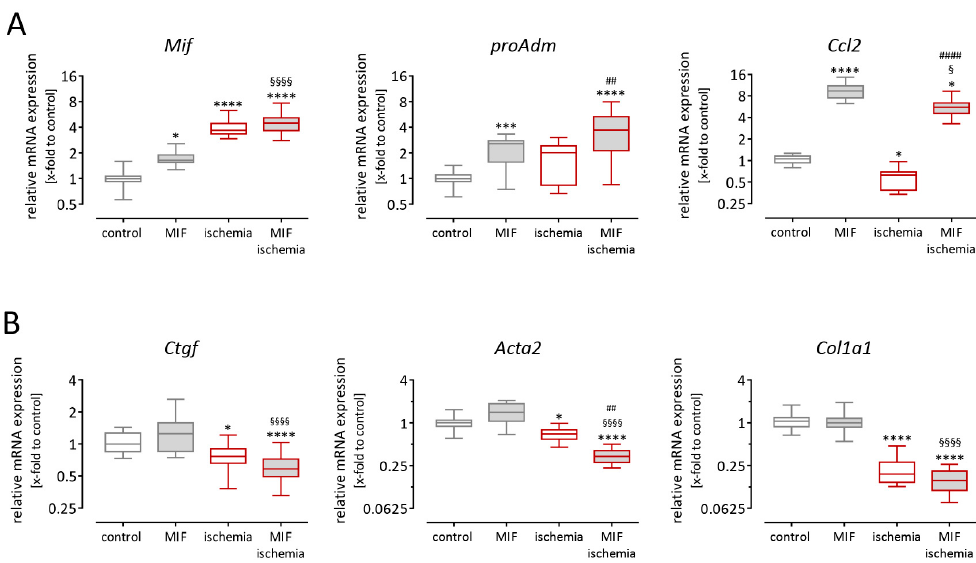
Figure 5. Pro-inflammatory and fibrotic signaling in cardiac fibroblasts exposed to ischemia in the presence of MIF. Murine cardiac fibroblasts were stimulated using 50 ng/mL recombinant murine